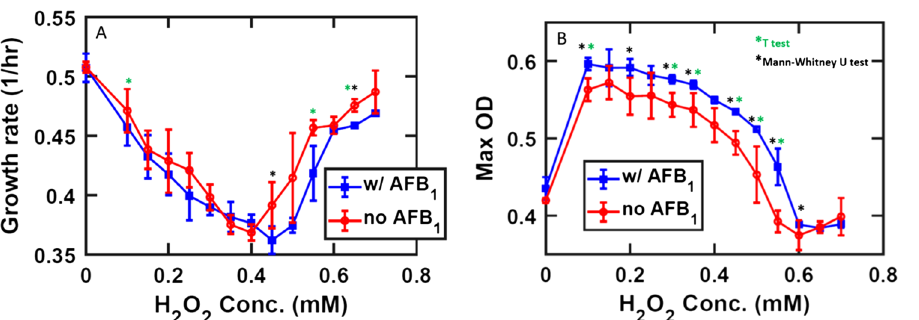
Figure 4. A postulated reaction scheme of AFB 1 degradation after exposure to APAB.